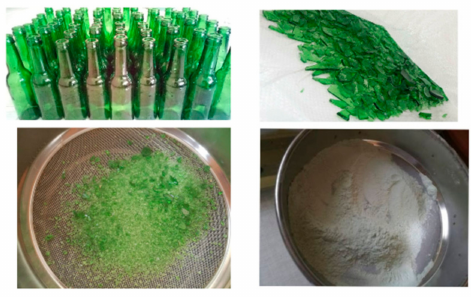
Figure 1. Glass powder preparation.